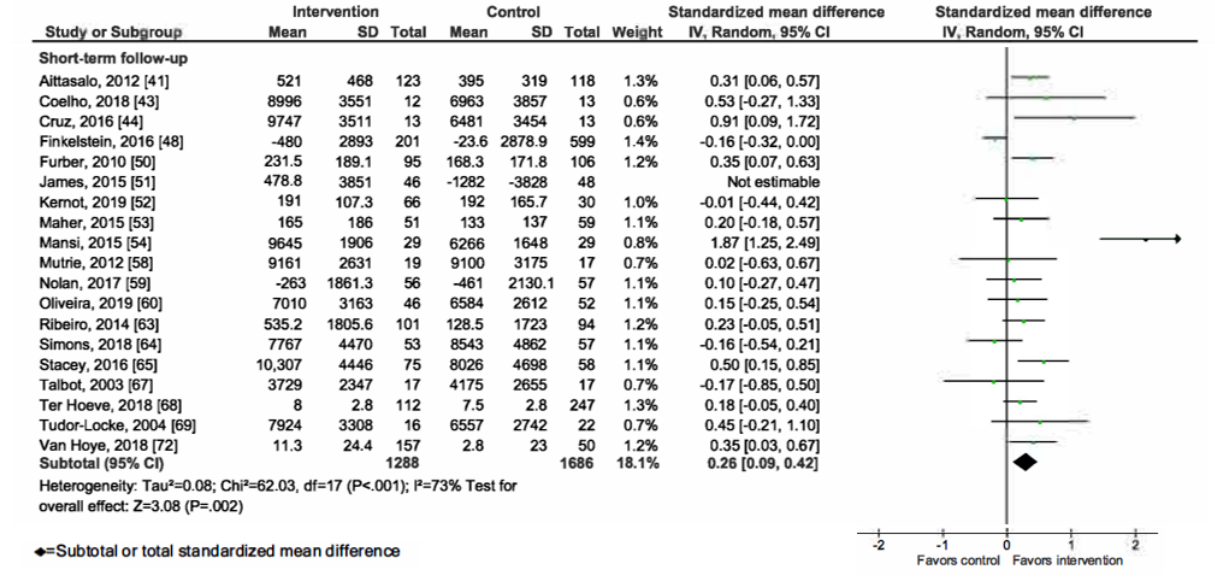
Figure 3. Primary outcome analysis for the outcome walking at timepoint short-term follow-up.